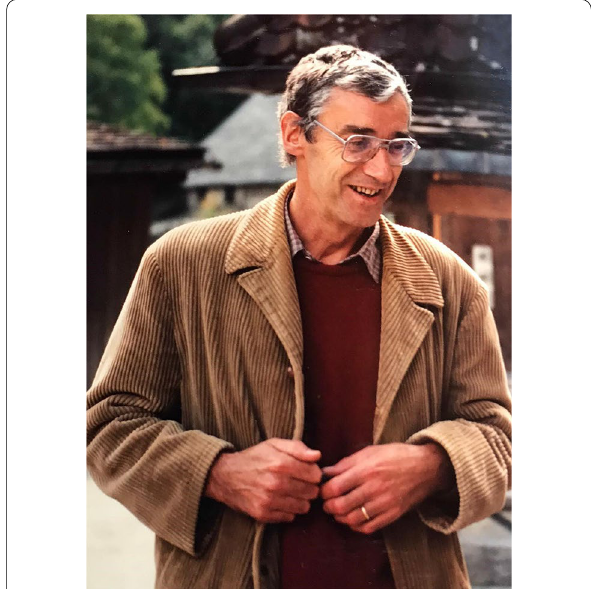
Fig. 1 Peter Jung as director of the NMB at the age of 55 in 1992 during a visit to the outdoor museum Ballenberg near Brienz, canton